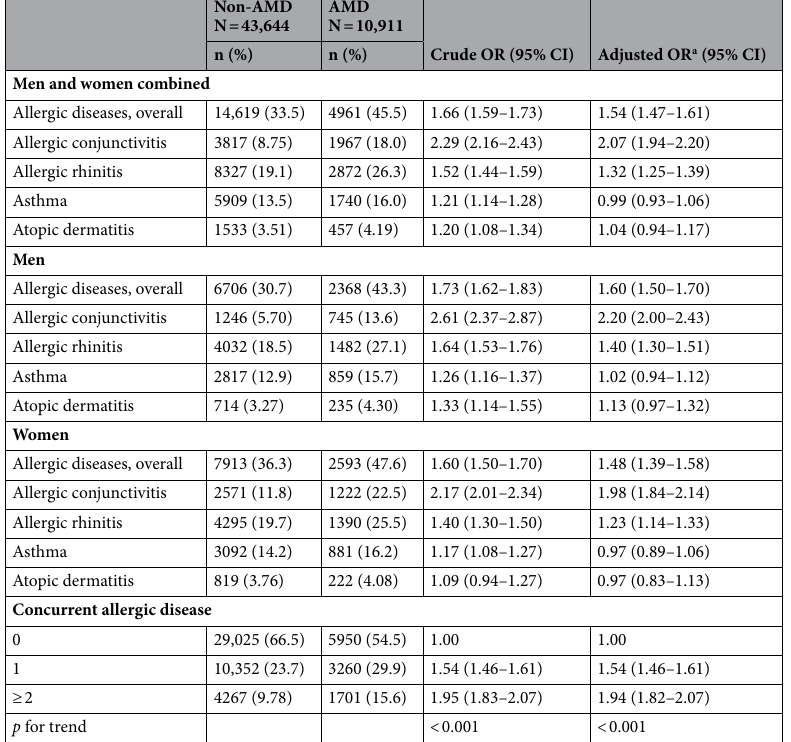
Table 3. Association between AMD and overall, specific, and concurrent allergic diseases. AMD age-related macular degeneration, CI confidence interval, OR odds ratio. a Model was adjusted for sex, age, urbanization level, occupation category, monthly income, and comorbidities of hypertension, diabetes, hyperlipidemia, and obesity.